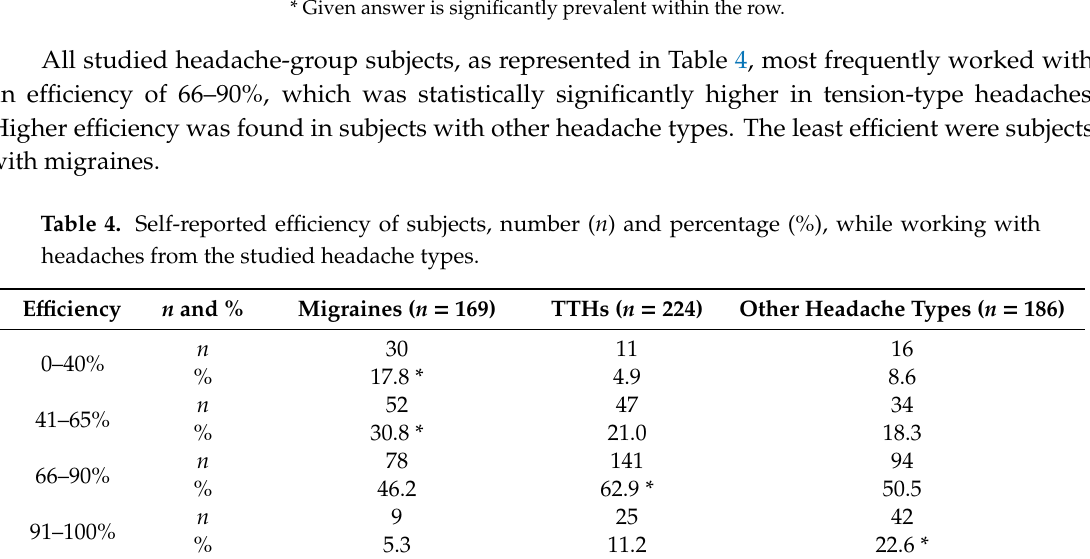
25–40 * 0 h * 9–24 h * 0.056 ≥ 41 * 1–8 h * 0–40% * 66–90% * 91–100% * 0.042 41–65% * Sometimes * Never * Always